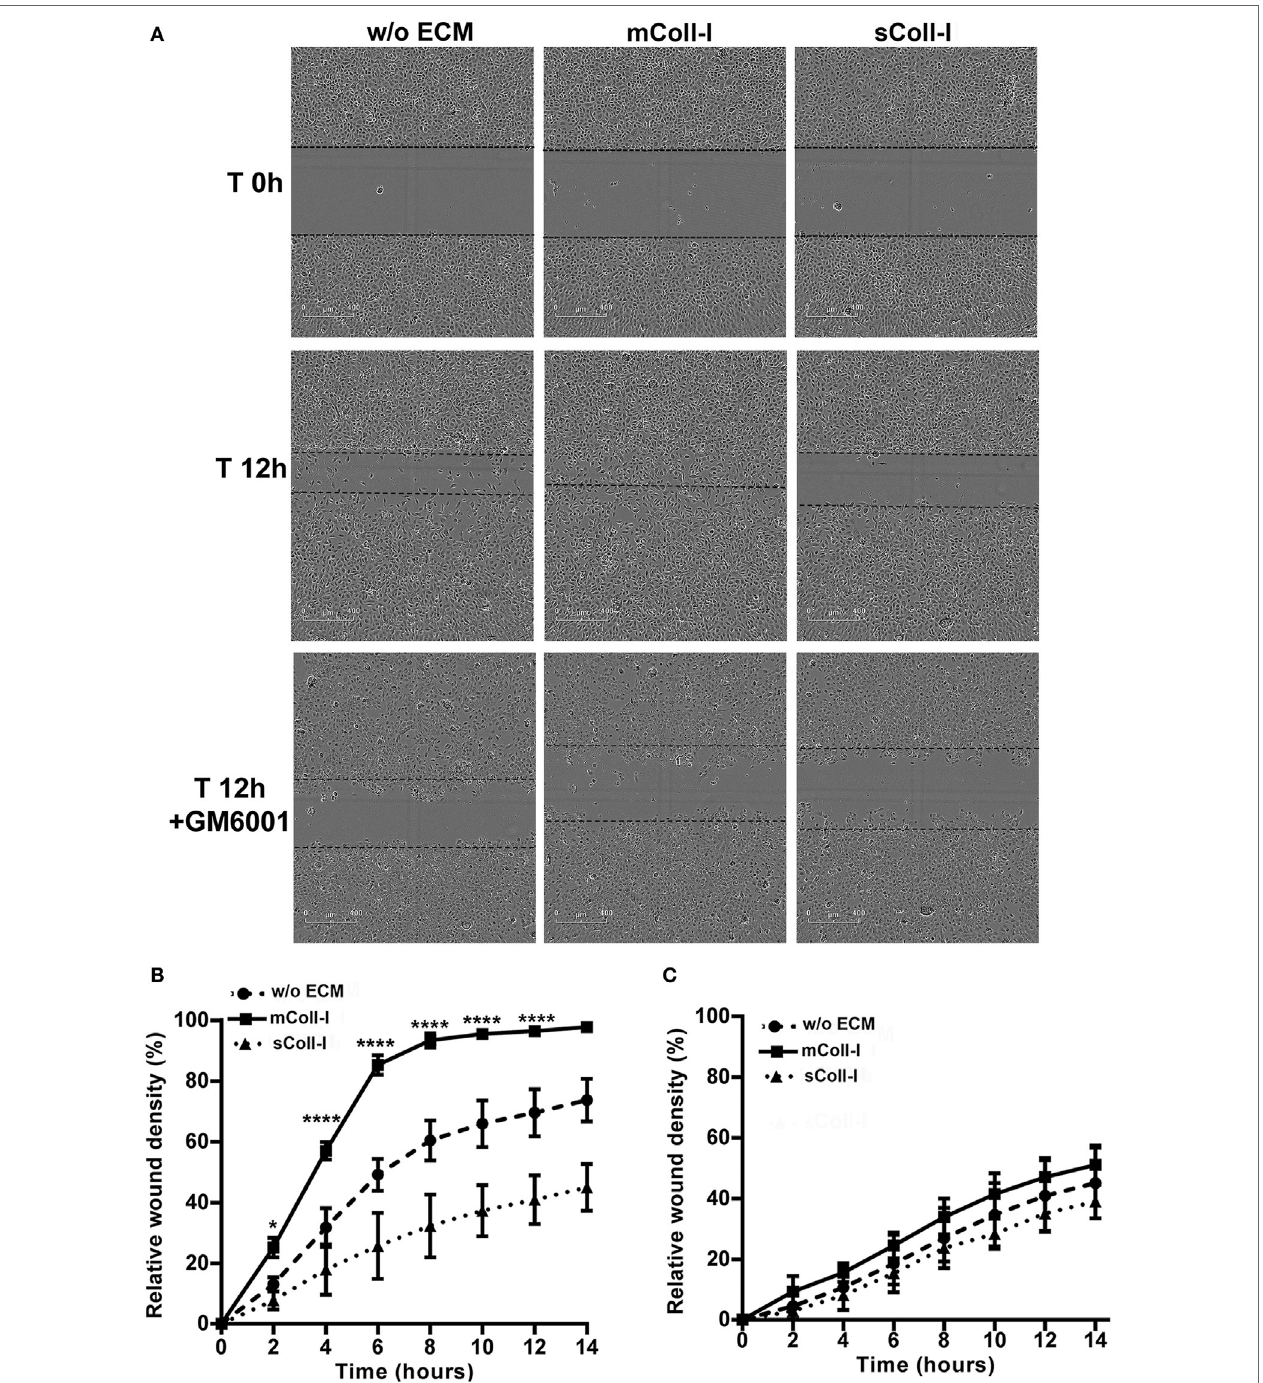
FigUre 5 | Type I collagen matrix enhances respiratory epithelial cell migration and wound repair in TB. Human bronchial epithelial cells (HBECs) were cultured in the absence of matrix [w/o extracellular matrix (ECM)] or in the presence of matrix type I collagen (mColl-I). Wells without mColl-I were pre-coated with poly- l -lysin. Collagen in solution was also added as control (sColl-I). Cells were stimulated with CoMtb with or without 10 µM GM6001. Images were acquired at 2 h intervals from wound creation and figures shown time 0–14 h. (a) Images acquired at time 0 and 12 h post-wound creation from CoMtb stimulated HBECs w/o ECM, with mColl-I or sColl-I and 10 µM GM6001. Scale bars: 400 µm. Relative wound density coverage was analyzed for wells with: (B) CoMtb; or (c) CoMtb and 10 µM GM6001chemical inhibitor. Relative wound density correspond to the amount of wound coverage by migrating cells. Plots show means and SD of four replicate wells and are representative of at least two independent experiments. p -Values were obtained with a two-way ANOVA, with Bonferroni correction for multiple comparisons. * p -value < 0.05, **** p -value < 0.0001.